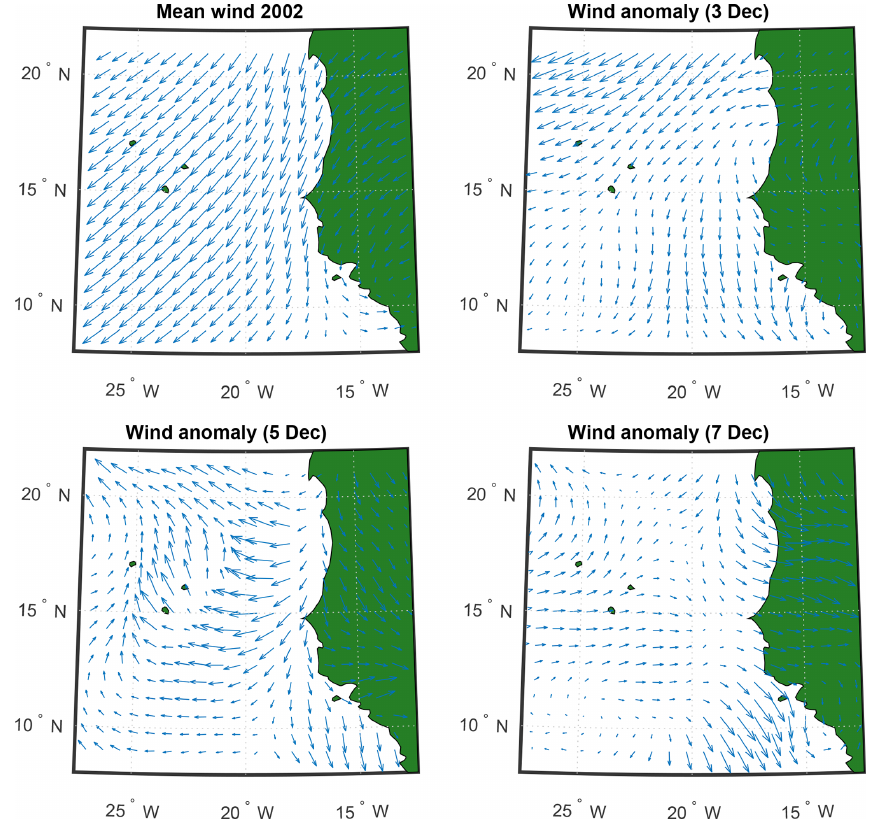
Figure 3. Mean wind velocity in December 2002 (maximum (cid:39) 8ms − 1 ) and wind velocity anomaly on 3, 5, and 7 December (maximum (cid:39) 4ms − 1